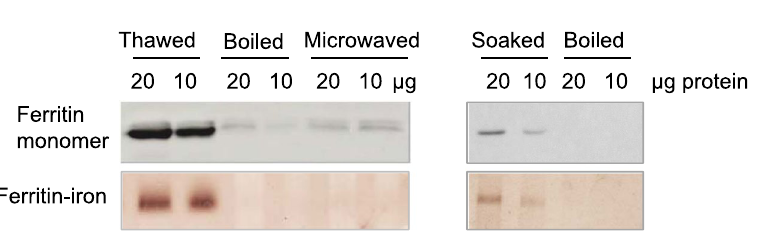
Figure 6. Ferritin in immature frozen peas and mature dry pea seeds is destabilized by different cooking methods. Frozen garden peas were boiled or microwaved, and mature dry peas were soaked and boiled. Protein extracts were analysed for ferritin monomer by protein blot analysis (top panel) and for iron associated with ferritin by in-gel Perls’/DAB staining (lower panel). The data are representative of 2 biological